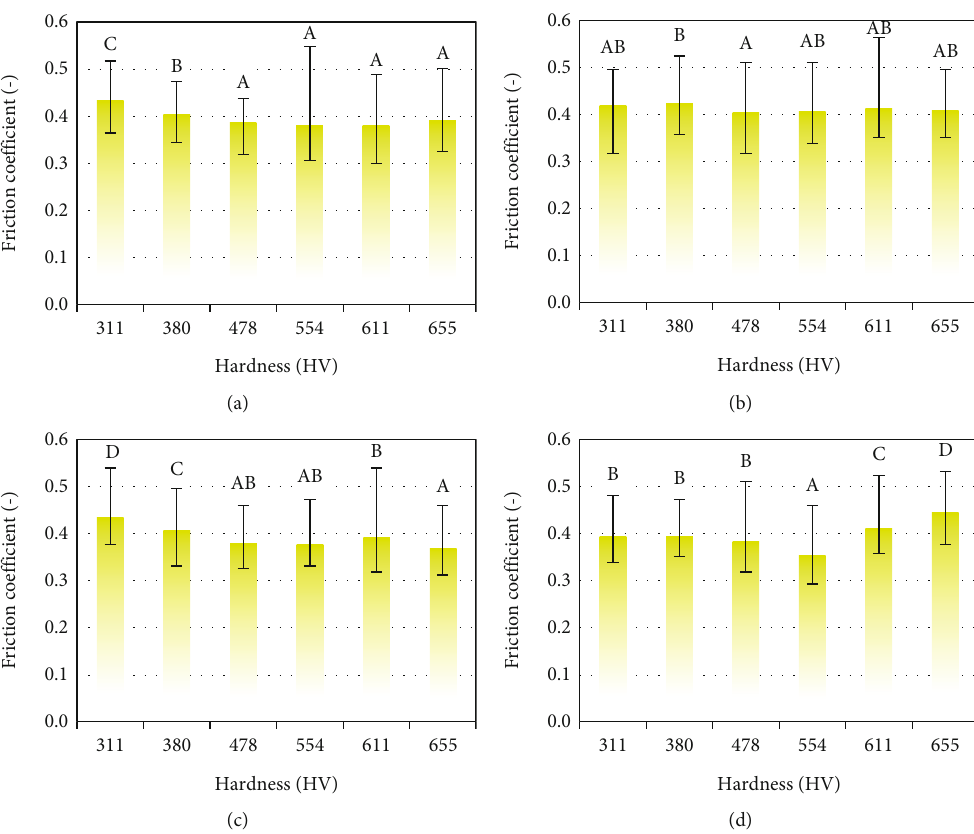
Figure 6: The coe ffi cient of static friction (mean value and minimum – maximum value) of cereal kernels on friction plates with di ff erent hardness and perpendicular surface orientation: (a) barley; (b) oats; (c) rye; (d)